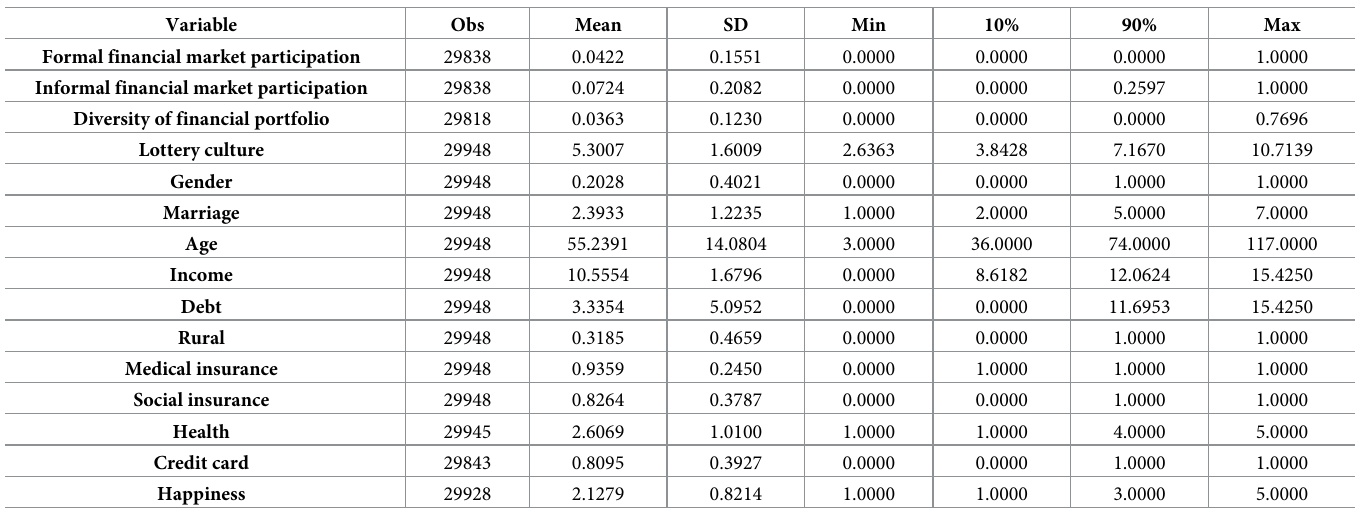
Table 2. Summary